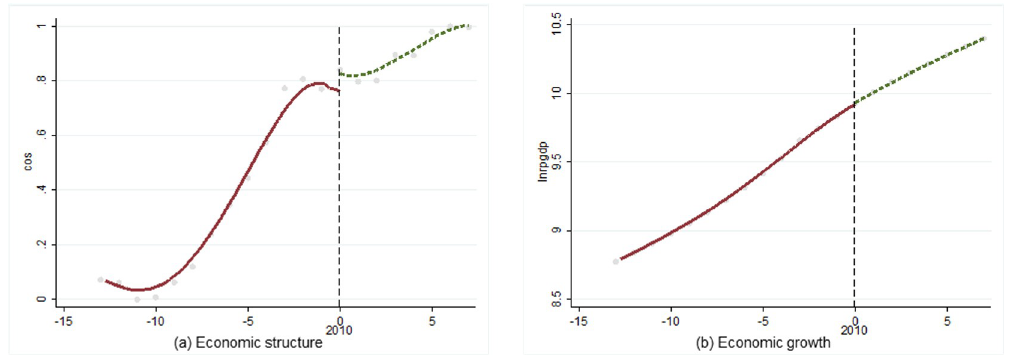
Fig 5. Discontinuity point in 2010 (upper-middle-income